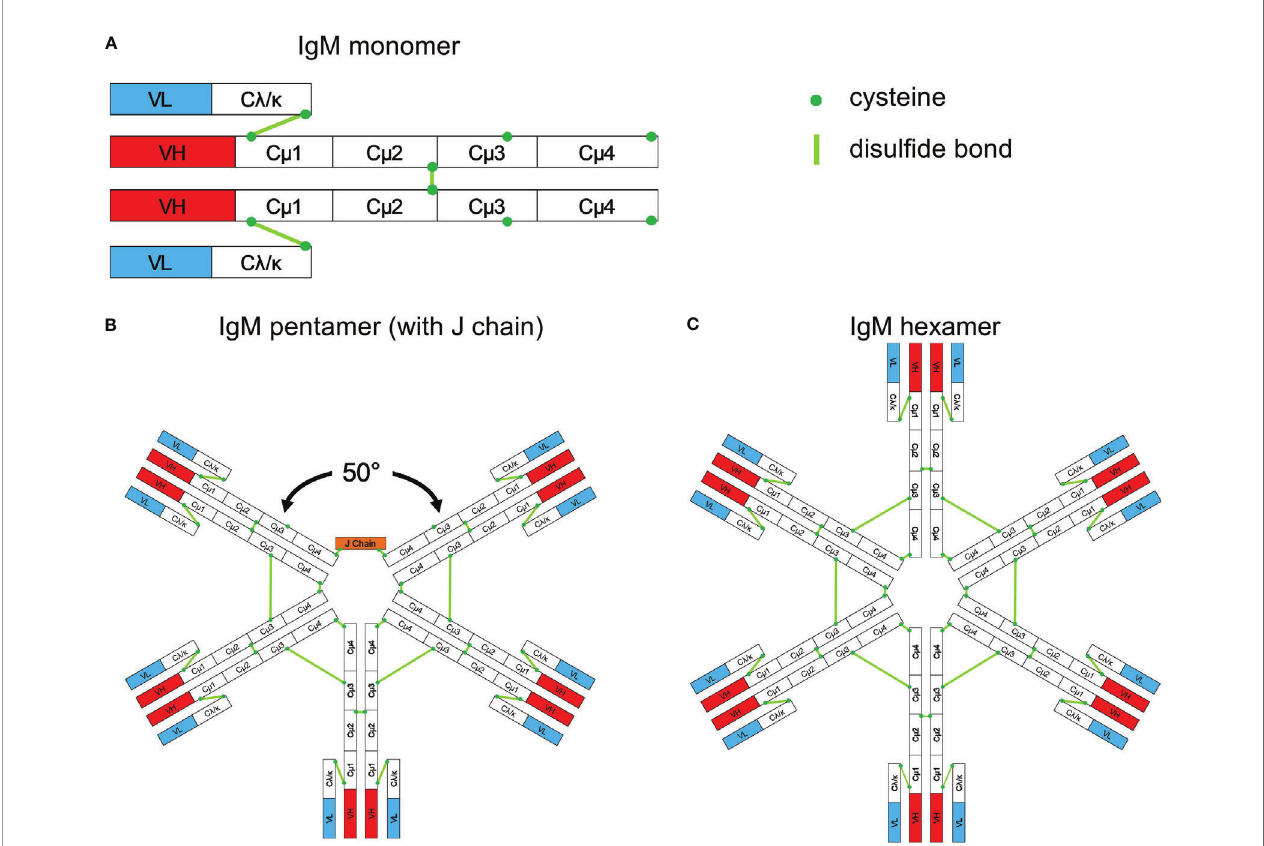
FIGURE 8 | Schematic structure of IgM. (A) Monomeric IgM is composed of two heavy ( m ) and two light ( l / k ) chains. Each heavy or light chain contains one variable region (VH or VL) and one constant region (C m 1-4 and C l / k ). (B) Pentameric IgM contains fi ve monomers and one J chain; disul fi de bonds between each monomer form the pentamer; the structure shown in (B) is based upon the recent electron microscopy image presented by Hiramoto et al. (221). There is a 50° gap where the J chain resides. (C) The IgM hexamer contains six monomers and resembles a hexagon. The J chain is generally absent in hexamers. With permission from Gong and Ruprecht,